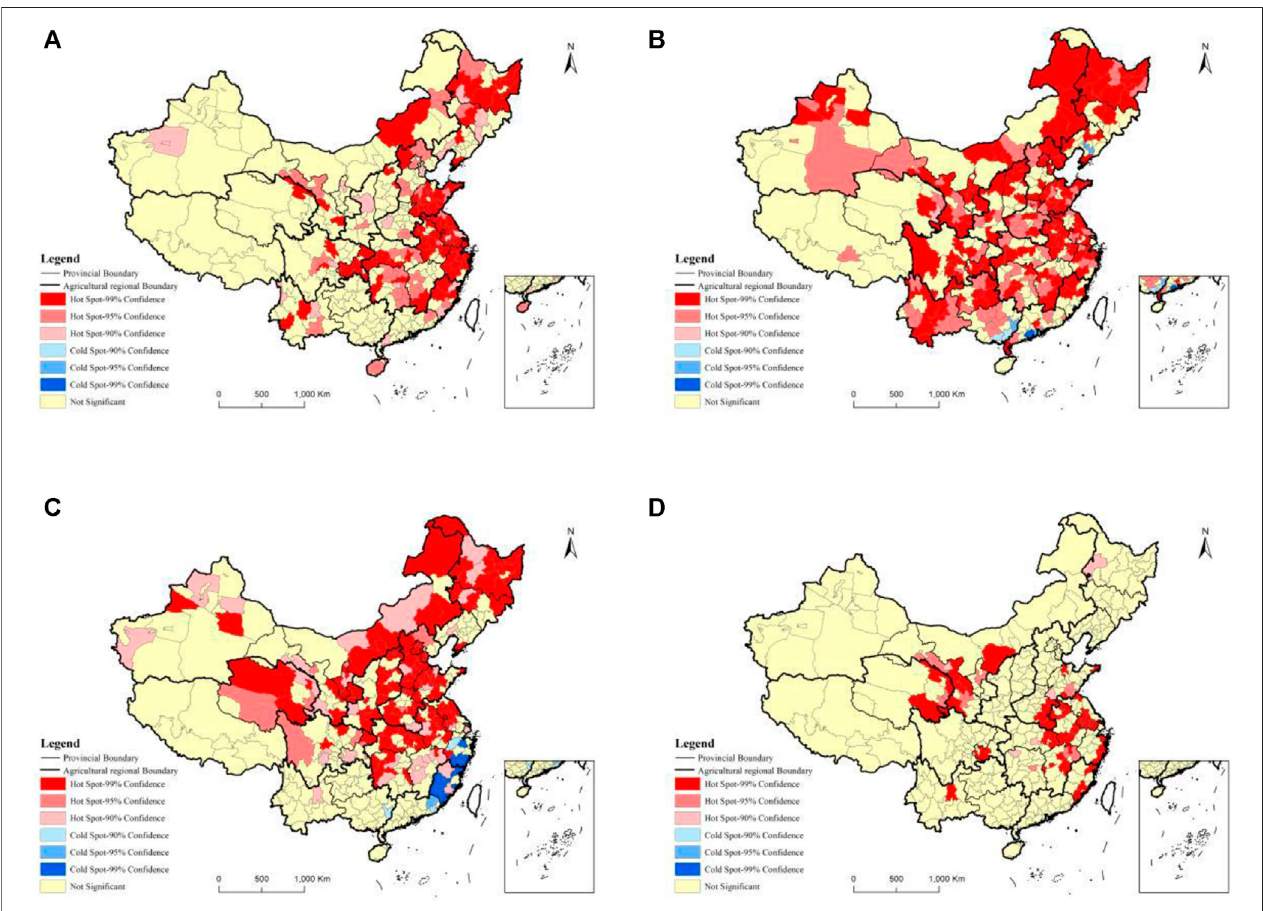
FIGURE 3 | Spatial aggregation of the four sectors: (A) plant product enterprises, (B) process enterprises, (C) livestock and poultry product enterprises, and (D) fi shery product enterprises.